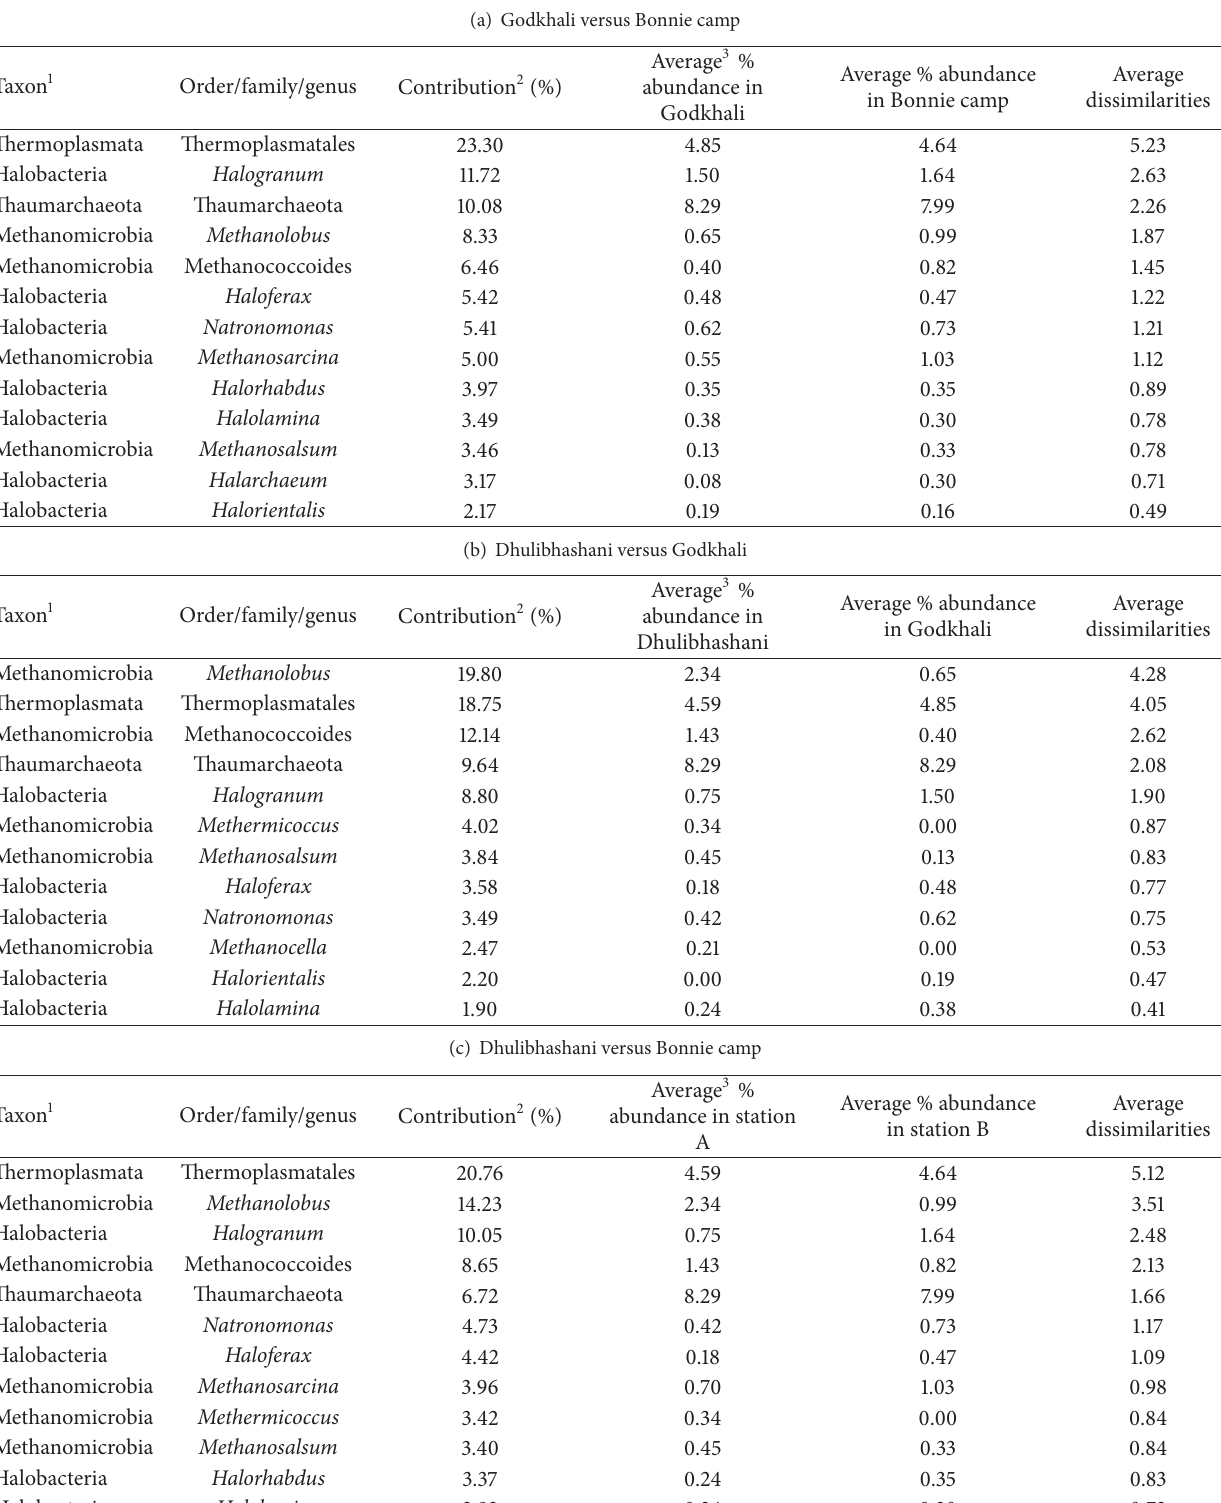
Table 4: Results of SIMPER (Similarity Percentage) analyses indicating the contribution of specific taxa to observed differences in archaeal community structure among the stations. (a) shows differences between Godkhali and Bonnie camp; (b) shows differences between Dhulibhashani and Godkhali; and (c) shows differences between Dhulibhashani and Bonnie